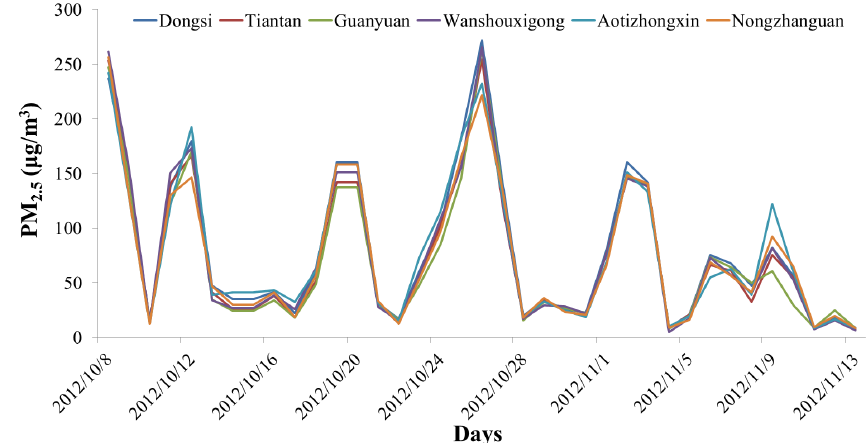
Figure 5. Daily PM 2 . 5 from six ground stations in the Chaoyang, Dongcheng, and Xicheng districts.